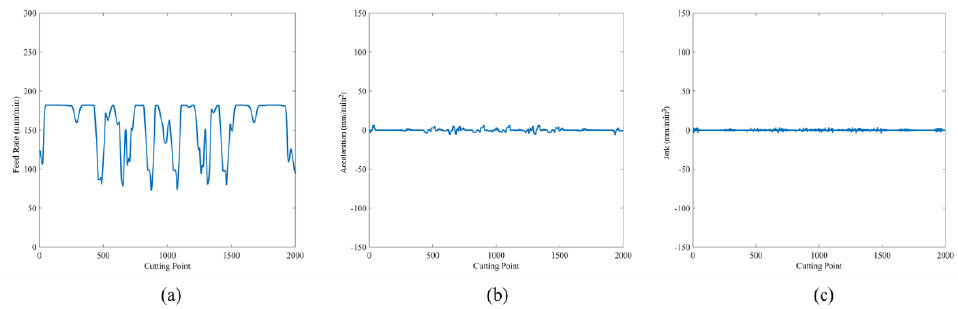
Figure 28. Cutting butterfly shape using our method with maximum feed rate of 185 mm/min: ( a ) feed rate, ( b ) acceleration, and ( c ) jerk.